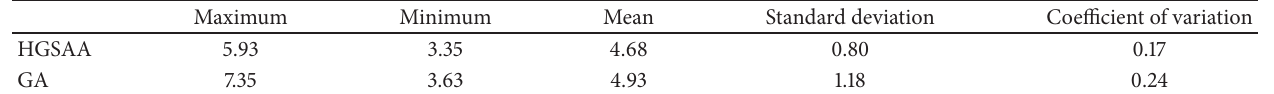
Table 3: Statistics results of CPU time for calculation of two